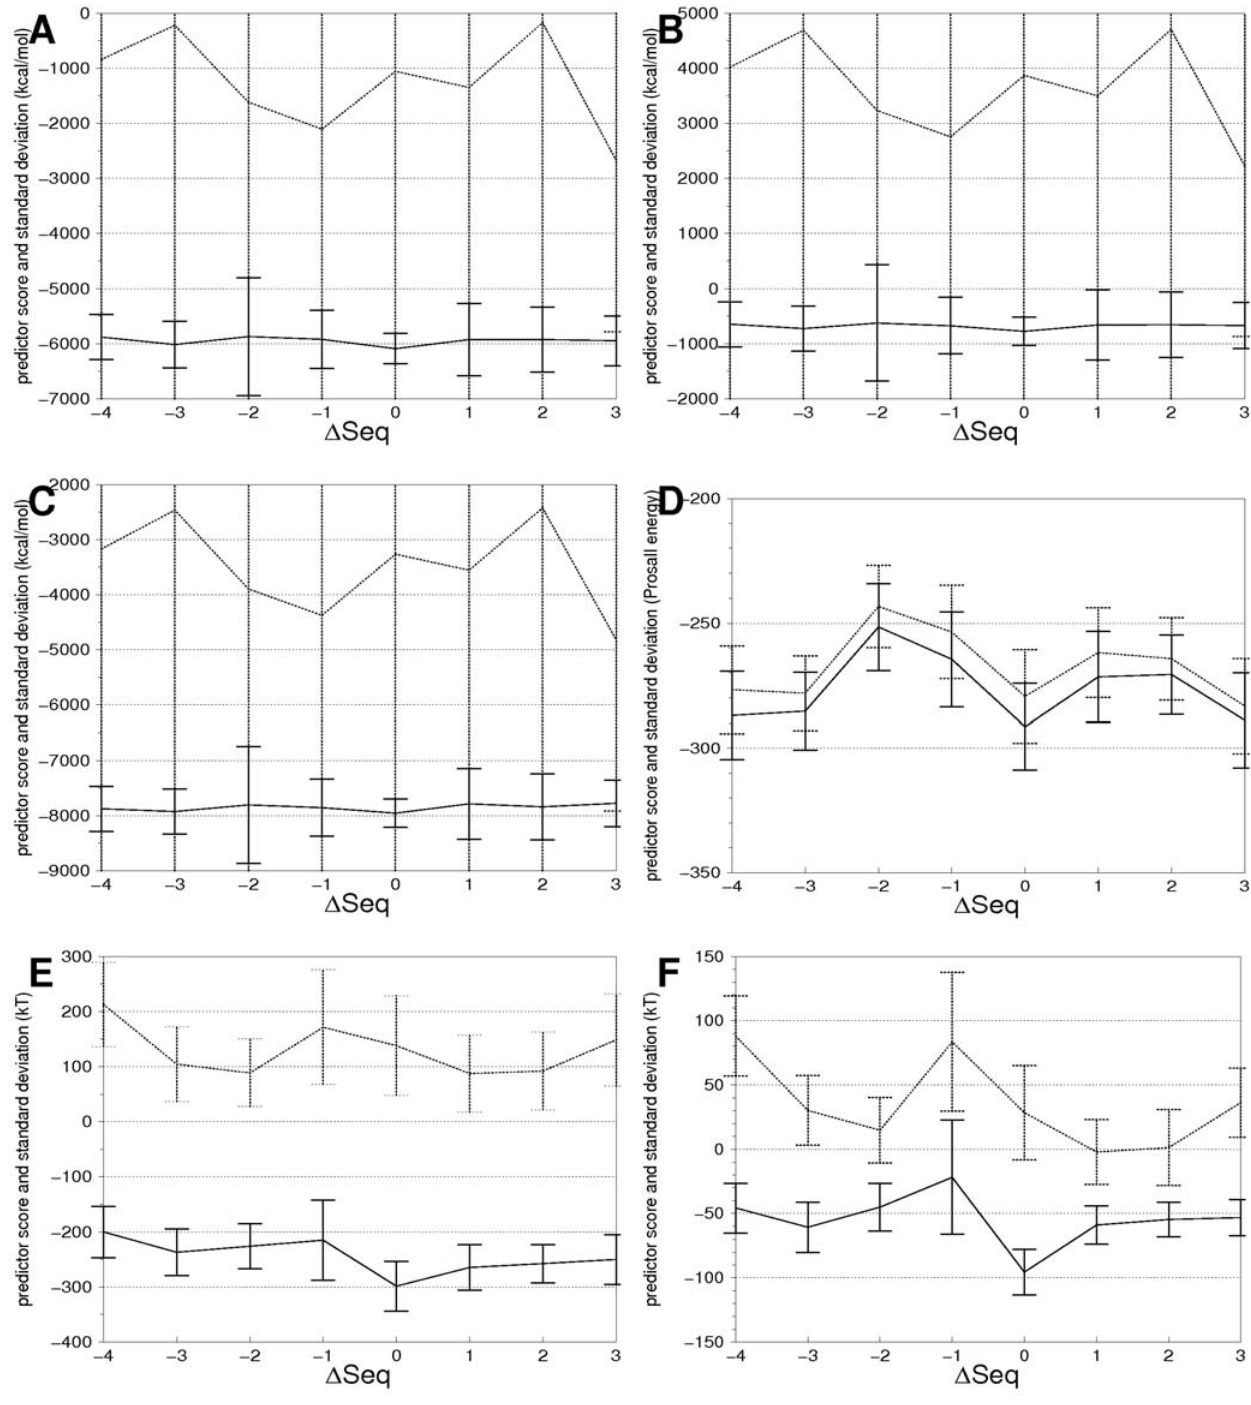
Figure 5. Influence of energy minimization for six different predictors CDIE/All (A), RDIE/All (B), GBMV2/All (C), ProsaII/All (D), ANOLEA/All (E) and ANOLEA/SSE (F) applied to the test case 1flp helix1. The six corresponding profiles and their standard deviation are shown for minimized and non minimized models, with plain and dotted lines, respectively. doi:10.1371/journal.pone.0002645.g005 The performance of the ANOLEA/ROI predictor is better than the All predictor, with associated p-values for successful prediction ranging from 3.0 ? 10 2 2 to 4.2 ? 10 2 32 . Compared to the ANOLEA/ All predictor, these lower p-values reflect a higher confidence as the residues selection is narrowed around the ROI.